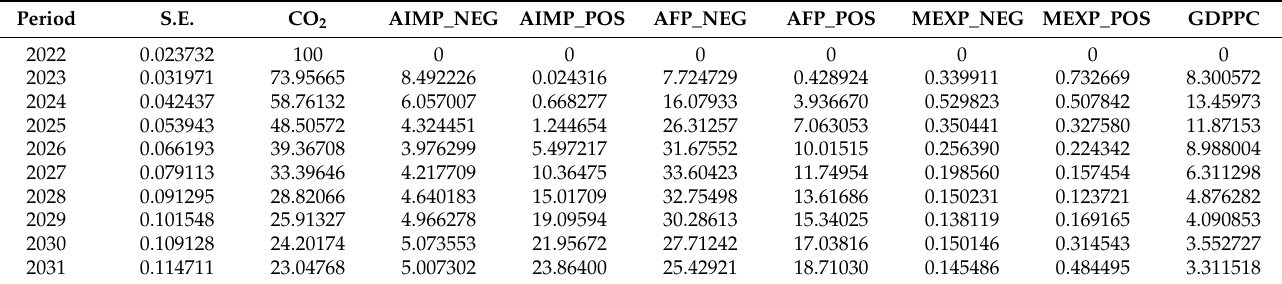
Table 9, in a similar line, estimated the asymmetric VDA of carbon emissions over a time horizon. Table 9. Asymmetric VDA estimates of CO 2